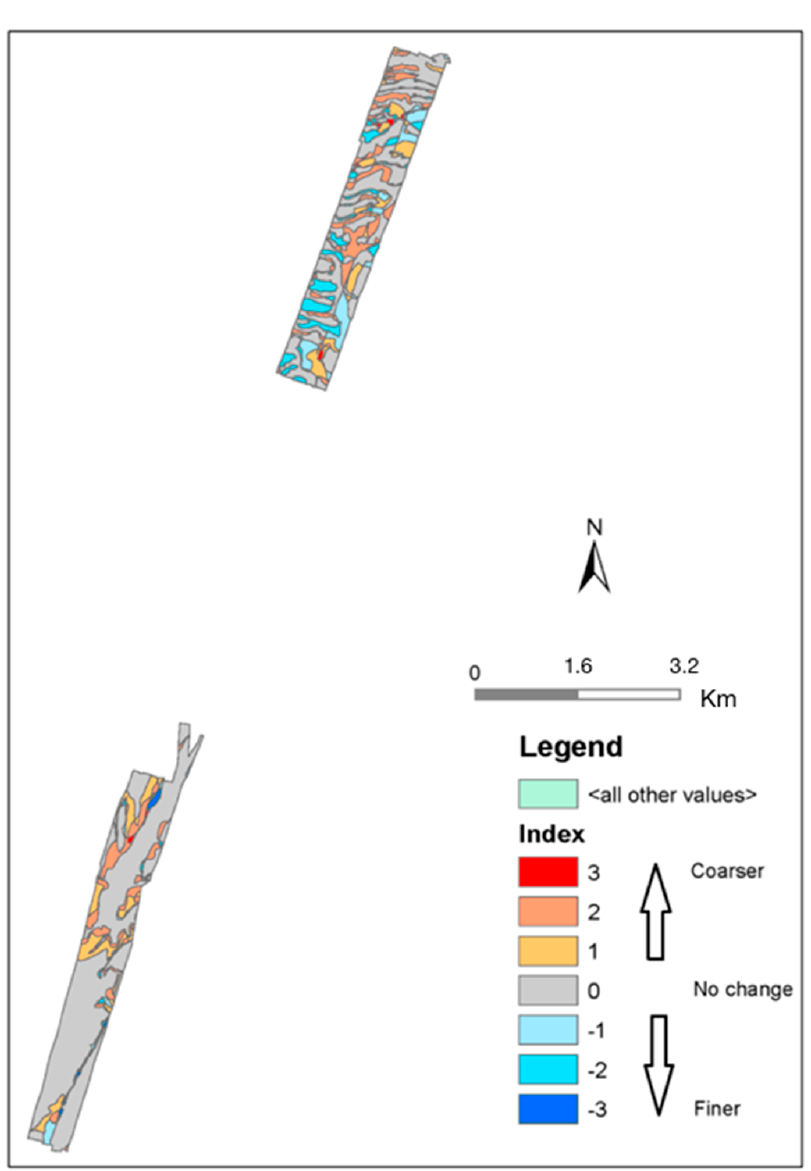
Figure 13. Sediment property change map for submerged resources of Assateague Island National Seashore between May 2015 and October 2015. Positive sediment property change index means seafloor became coarser, negative sediment property change index means seafloor became finer and zero value means sediment texture did not change.